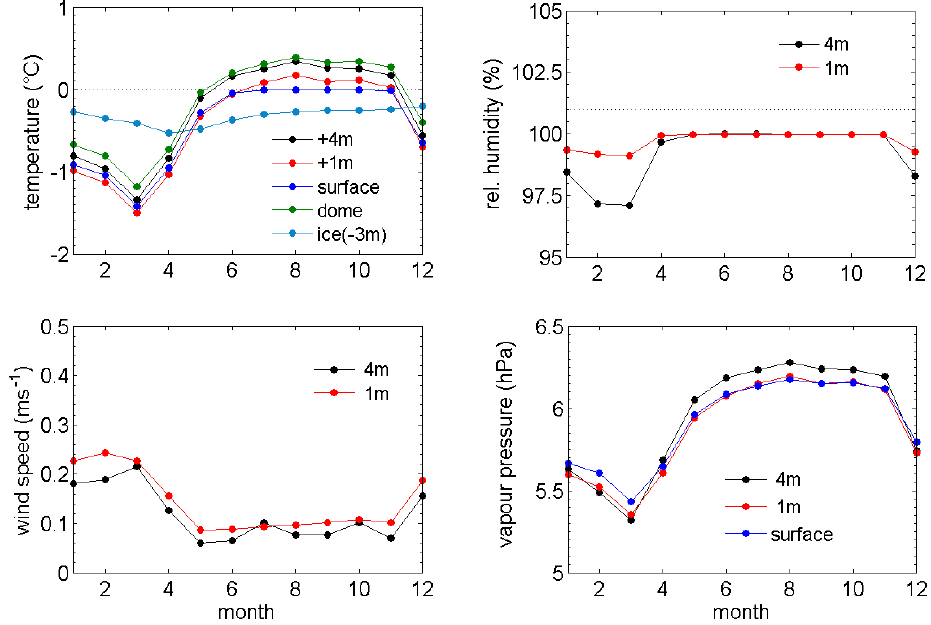
Fig. 3. Mean monthly values of measured temperatures (air, ice, rock) and humidity (upper panels) as well as of wind speed and vapour pressure (lower panels) at the EP measurement